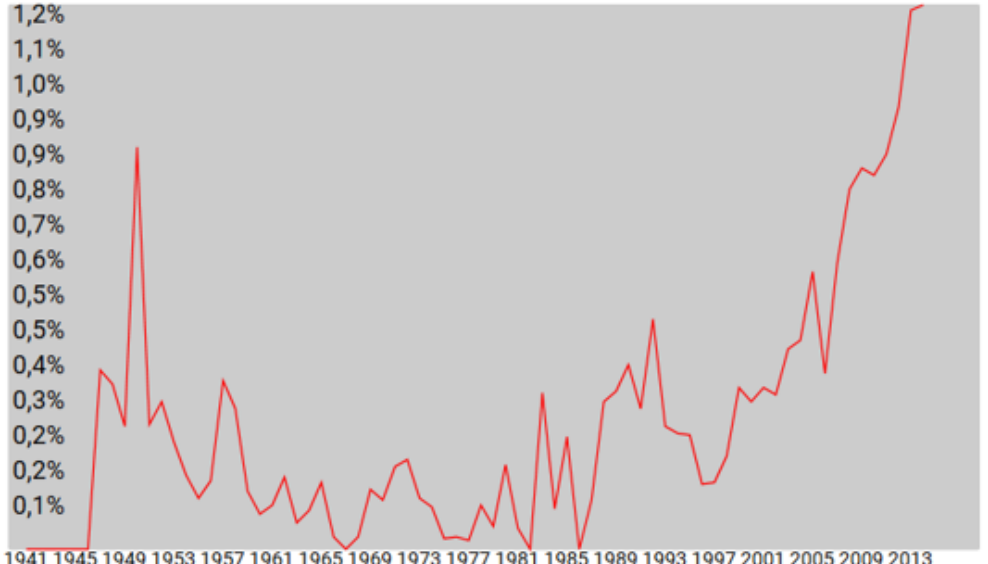
Figure 1. Relative frequency of the usage ‘refugee’ (‘Flüchtling’) in programs of 47 German adult education centres between 1947 and 2015 in